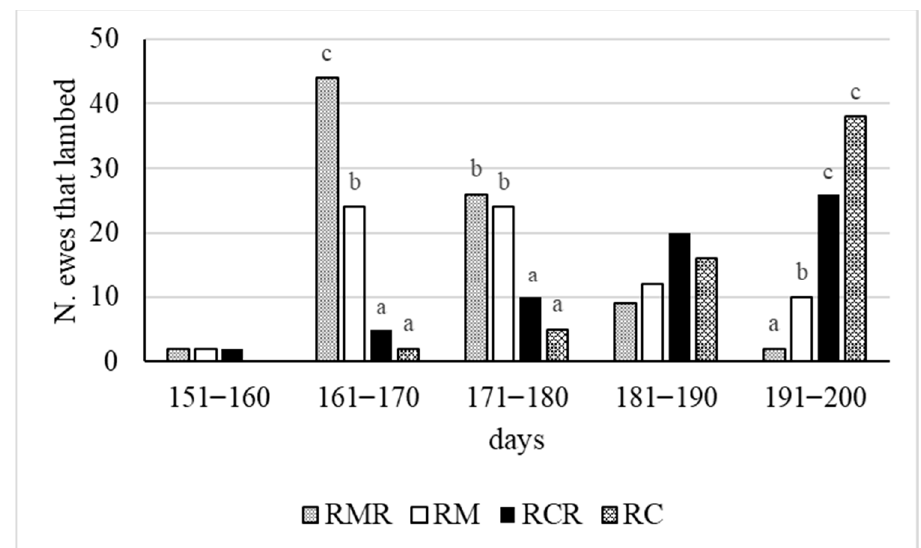
Figure 1. Number of ewes that lambed from 150 to 200 days (in 10-day periods) after ram introduction in the observed groups. The number of ewes that lambed in each 10-day period was compared by a Chi-square test. RC = ewes mated with untreated control rams; RM = ewes mated with melatonin-treated rams; RMR = ewes mated with rams treated with melatonin and replaced every 10 days; RCR = ewes mated with untreated control rams replaced every 10 days. Different letters (a, b, c) indicate a difference for p ≤ 0.01.